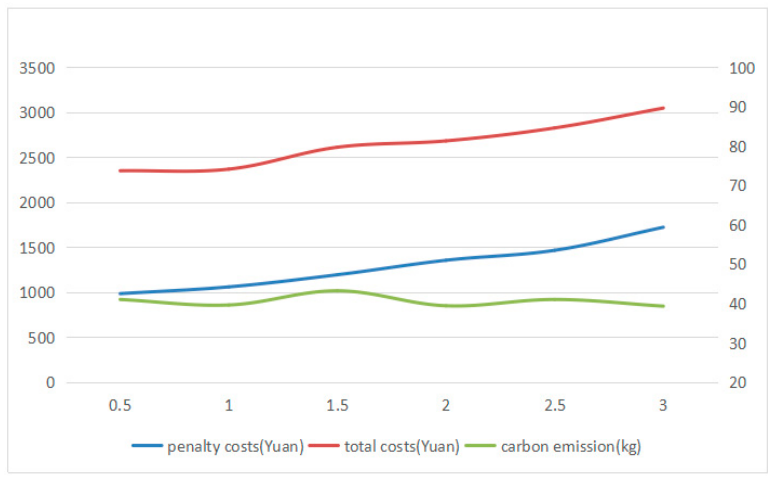
Figure 7. The change of penalty costs, total costs, and carbon emission under different charging time.